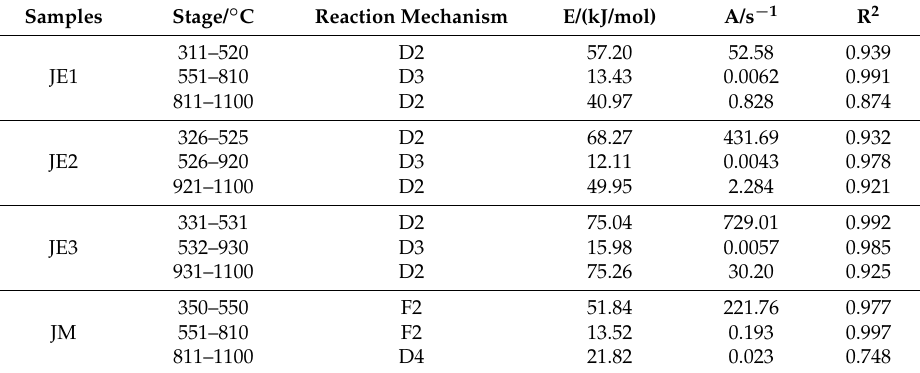
Table 8. Kinetic parameters of the coal/coal-iron ore briquette at different reaction stages.